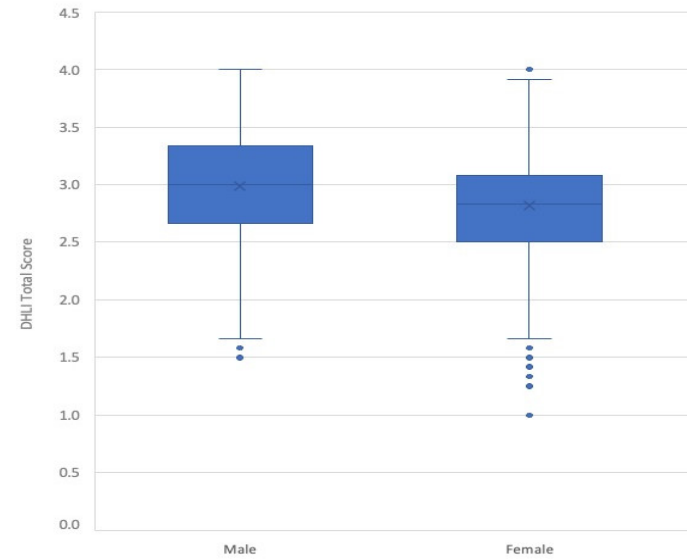
Figure 1. Box plot of the DHLI total score by gender ( N =2996) .